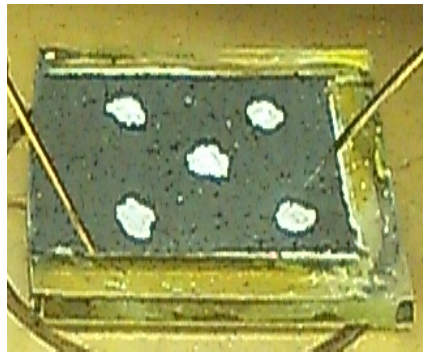
Figure 6. Photograph of ITO/CdS/PbSe heterostructure (real device).